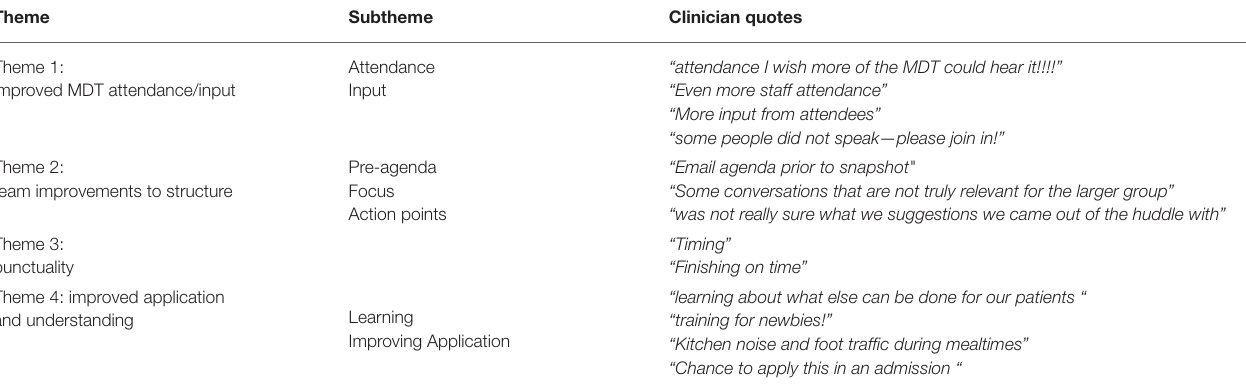
TABLE 5 | A table showing example quotes from each theme and subtheme identified from responses to question 3 “what could be improved about the huddle?” Theme Subtheme Clinician